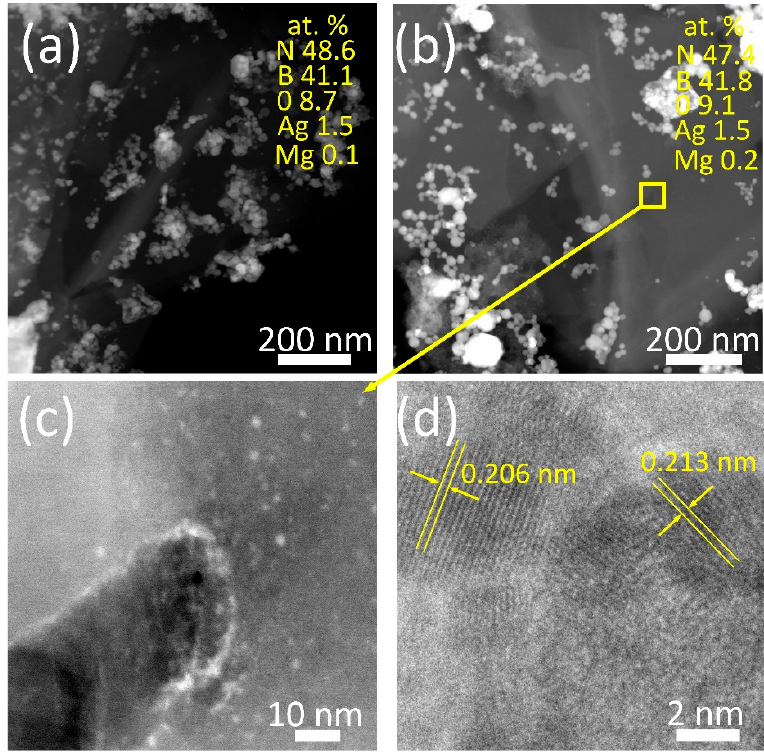
Figure 5. HAADF STEM ( a – c ) and high-resolution TEM ( d ) images of Ag/BN m ( a ) and Ag/BN a sam-